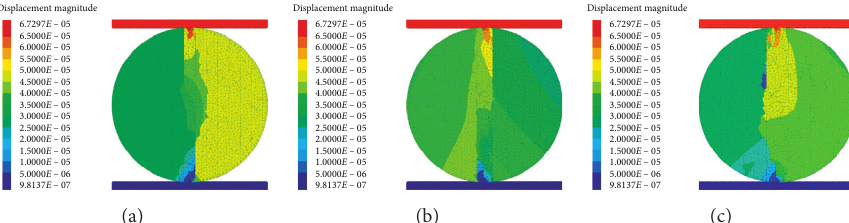
Figure 17: Cloud diagrams of loading and displacement with uniform and parallel bedding models with different layer thicknesses. (a) 3.6 mm. (b) 5.0 mm. (c) 7.1 mm.